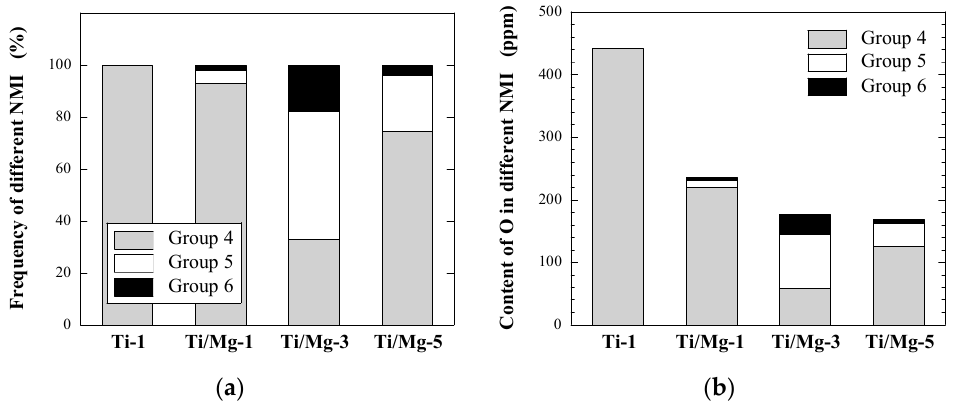
Figure 8. Average frequencies ( a ) and contents of oxygen ( b ) in different NMIs determined by the FGA method in the Ti and Ti/Mg deoxidation experiments.